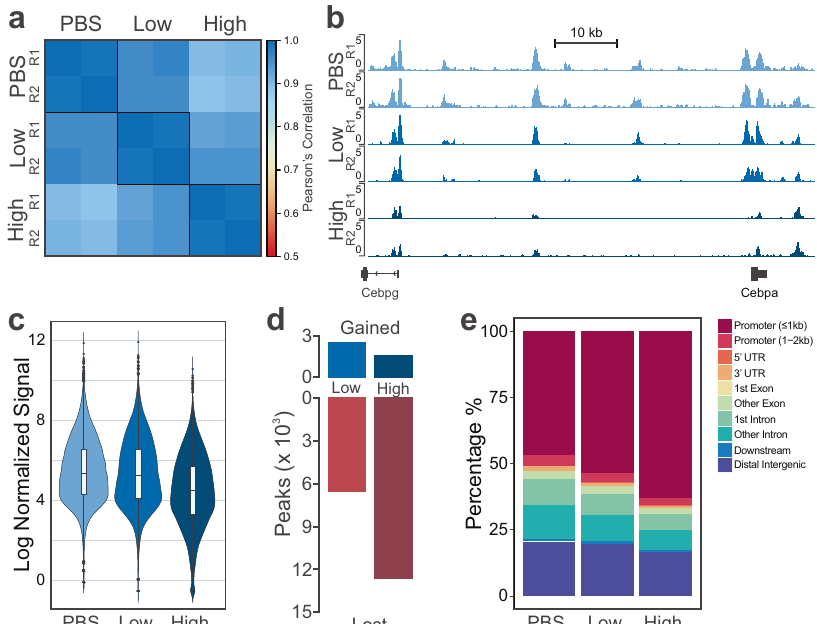
Fig. 2 Overview of epigenomic data for murine BMDMs dosed with PBS, low-dose LPS, or high-dose LPS. a Pearson ’ s correlation of normalized H3K27ac signal around promoter regions (TSS ± 2 kb). b Tracks of normalized H3K27ac signal for replicates dosed with PBS, low-dose LPS, or high-dose LPS (from top to bottom). Tracks are aligned in mm10 and the region displayed is chr7:35,042,108-35,138,618. c Distribution of normalized H3K27ac signal at peaks ( n = 29,071). The middle bar of the boxplot denotes the median. The upper and lower bounds of the box correspond to the 75th and 25th percentile, respectively. Each whisker spans up to the range of 1.5 * interquartile range from the edge of the box. d Number of peaks gained or lost in low- dose or high-dose conditions compared to PBS. e Percentage of peaks at genomic